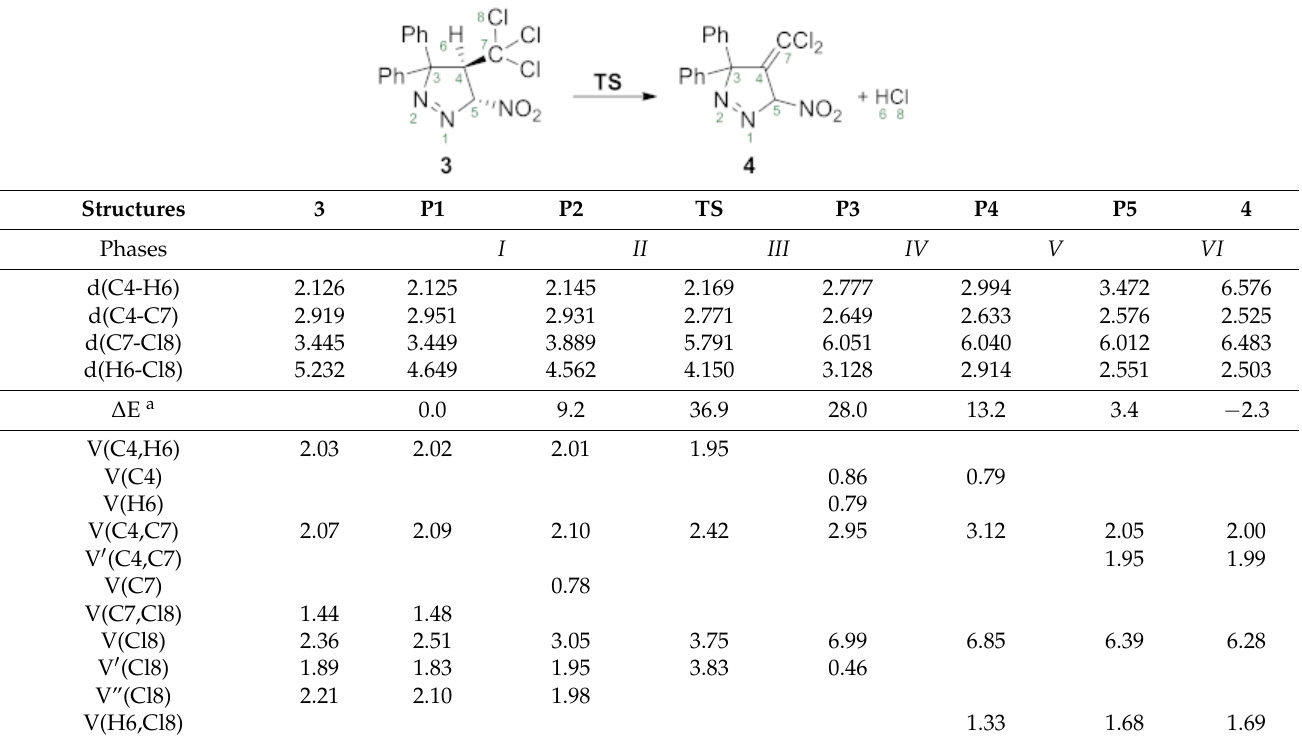
Table 1. B3LYP(PCM)/6-31G(d) ELF valence basin populations, distances of the breaking and forming bonds and relative a electronic energies of the IRC points, P1–4 , defining the sixdifferent phases characterising the reaction of the dehydrochlori- nation of 3 . The stationary points 3 , TS and 4 are also included. Distances are given in angstroms, Å, electron populations in average number of electrons, e, relative energies in kcal · mol − 1